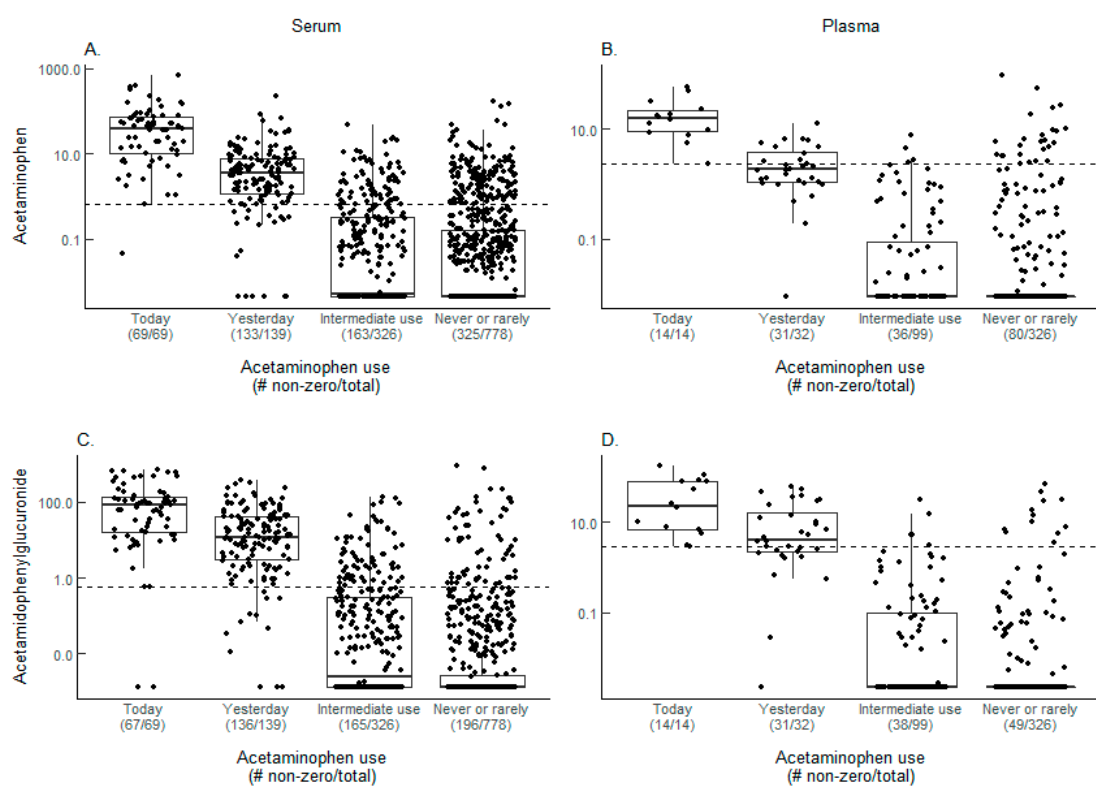
Figure 1. Acetaminophen metabolite levels. Box plots of acetaminophen metabolite levels from serum and plasma samples in log10 scale with undetected (zero) values adjusted to 80% of the minimum value detected for visualization purposes for ( A , B ) acetaminophen and ( C , D ) acetamidophenylglucuronide. The cutoff levels used to define use for each metabolite are represented by the dashed lines and are ( A ) 0.6578, ( B ) 2.369, ( C ) 0.5633, and ( D ) 2.9350. The number of samples with metabolites detected and the total number of samples analyzed are displayed beneath each self-reported use category. Because the metabolite levels are relative rather than absolute, no units are assigned to the levels.